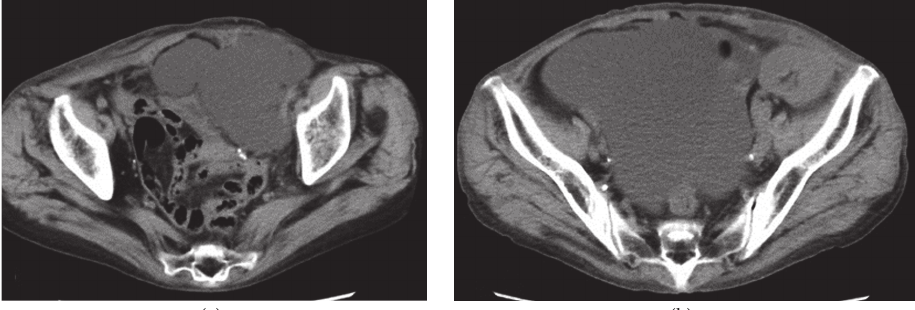
Figure 1: The lymphocele developed from around the graft to the front of the bladder after transplantation (a). The ascites developed and increased after fenestration surgery (b).